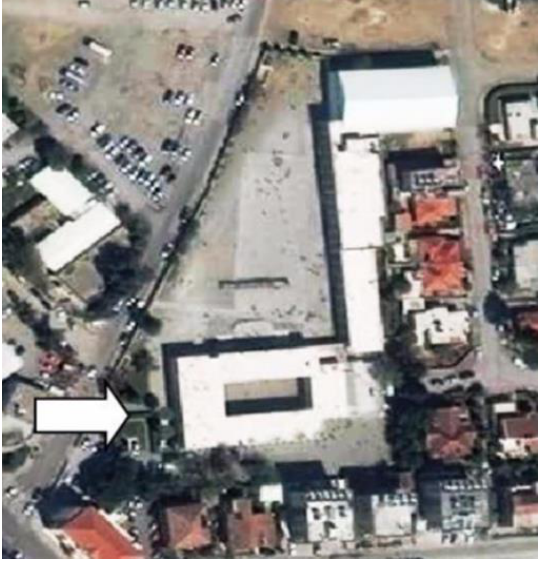
Figure 10. The site plan of Şehit Ertuğrul Ilkokulu